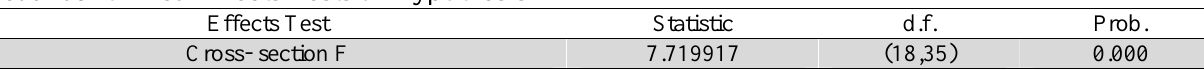
Redundant Fixed Effects Tests of Hypothesis 1